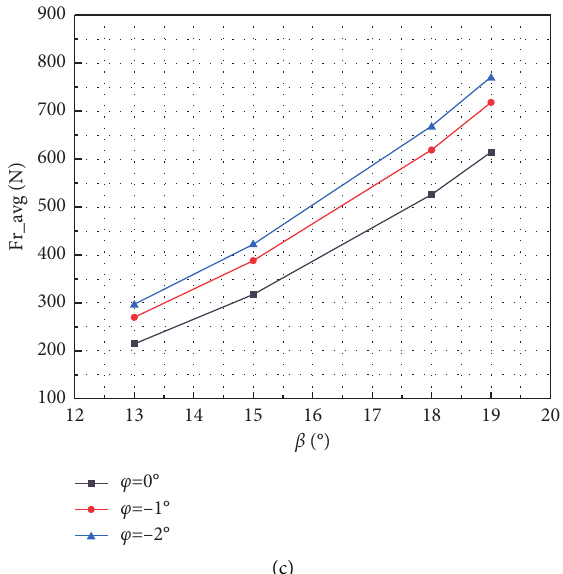
Figure 5: The average radial EMF versus turn-off angle for different turn-on angle. (a) θ � 7 . 5 ° . (b) θ � 15 ° . (c) θ � 22 . 5 °